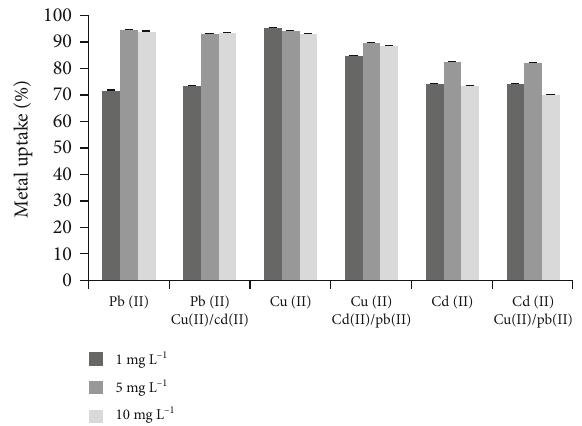
Figure 5: Comparison of the removal percentage of Pb(II), Cu(II), and Cd(II) between single metal and multimetal solutions at di ff erent initial concentrations: pH = 5 : 4 , adsorbent concentration = 2g L − 1 , and t = 2 h ( n = 3